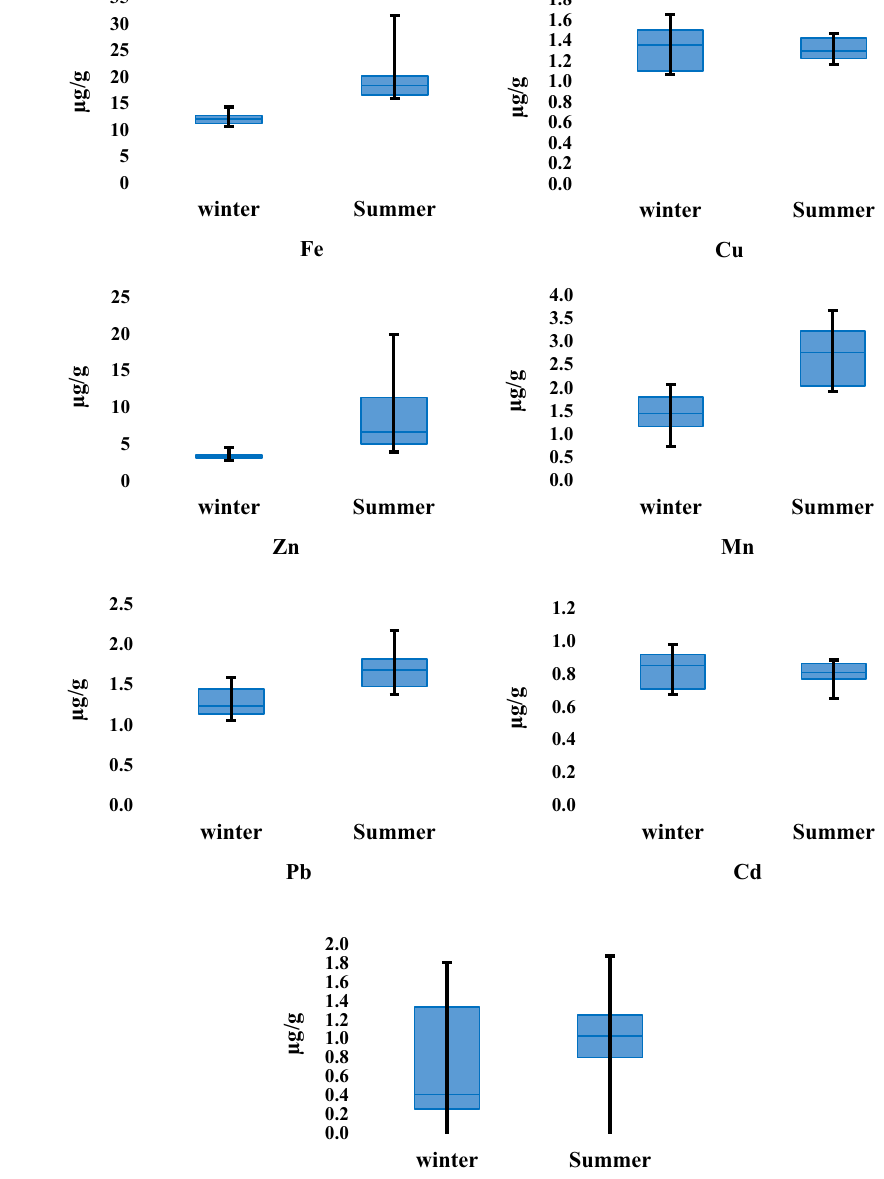
Fig. 3 Multiple box and whisker plots of the measured heavy metals concentrations in mus- cles of Oreochromis niloticus collected from Mariout